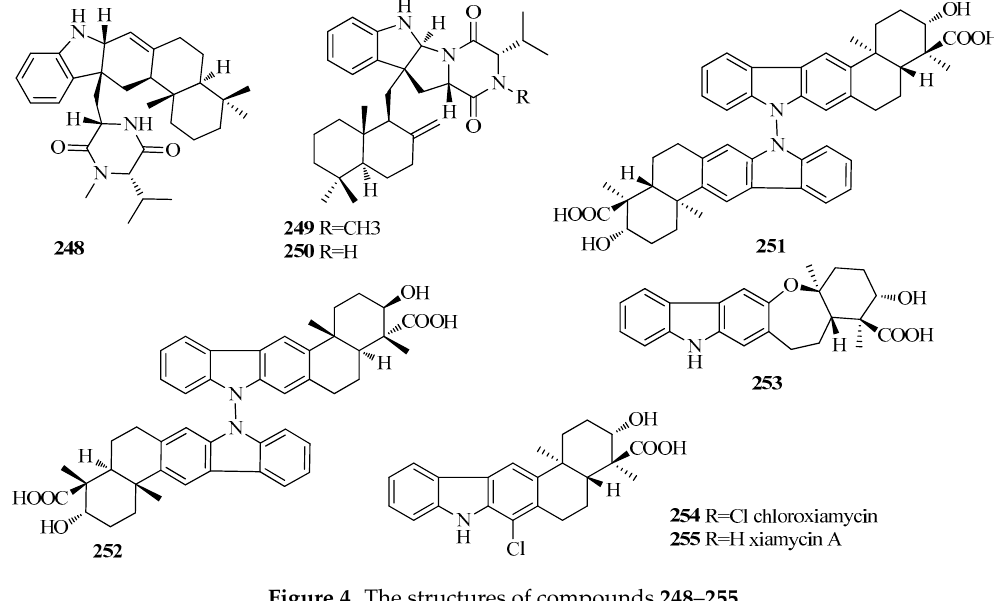
Figure 4. The structures of compounds 248 – 255.